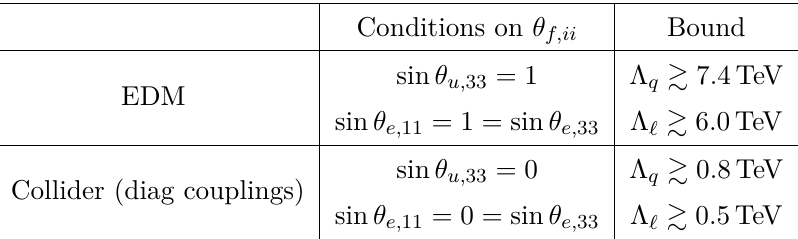
Table 8 . 95% C.L. limits on r 2 after χ 2 fits obtained on the data in refs. [66–69], when NP ψ contributes to all the Yukawa couplings. These results holds for the MFV case, while the FN one is likely to be very similar.